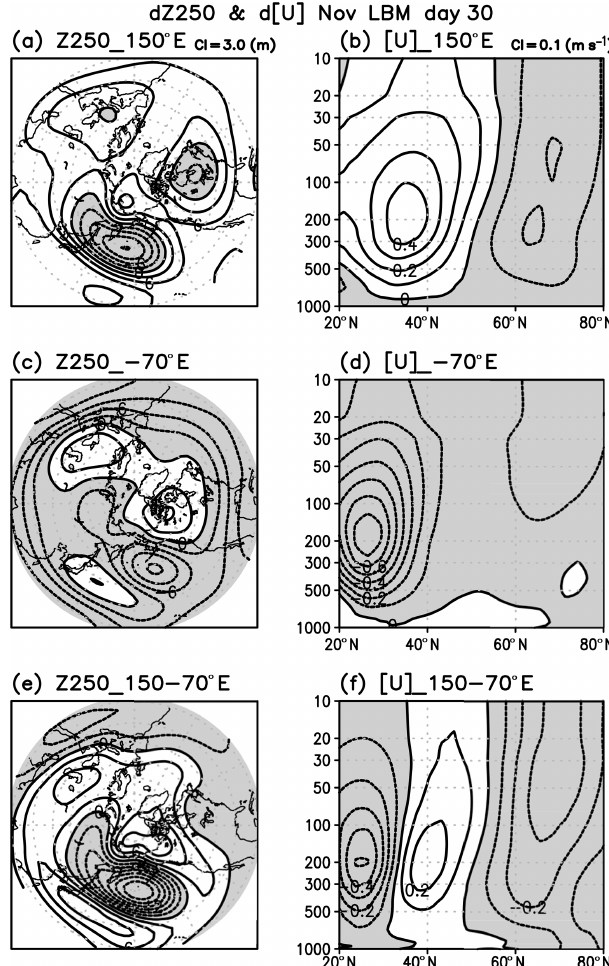
Figure 10. (a) Linear response of geopotential height at 250hPa (Z250) to the adiabatic heating centered at 5 ◦ N, 150 ◦ E, simulated by LBM with the November climatological background field. CI is 3m. (b) Same as panel (a) but for the response of the zonal- mean zonal wind (CI of 0.1ms − 1 ). (c) Same as panel (a) but for the adiabatic cooling centered at 5 ◦ N, 70 ◦ E. (d) Same as panel (b) but for the adiabatic cooling centered at 5 ◦ N, 70 ◦ E (e) . (a, c, f, b, d) In all figures, negative values are shaded. (e) Sum of panels (a) and (c) . (f) Sum of panels (b) and (d)